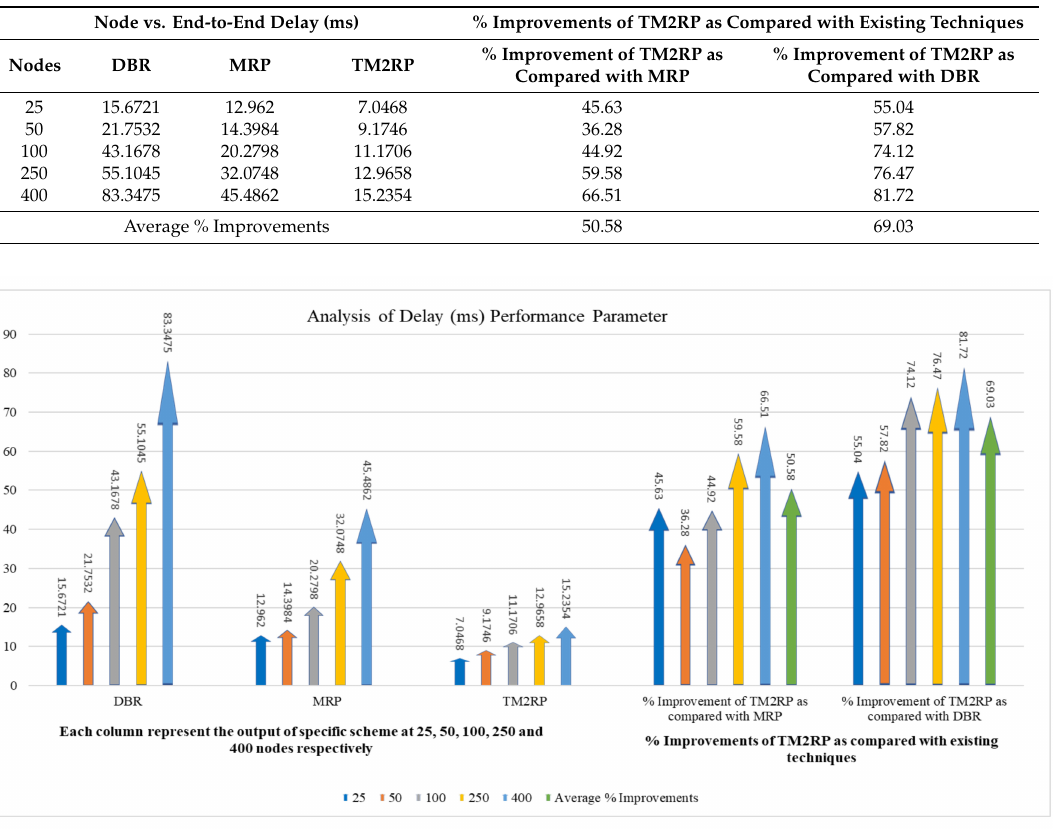
Figure 14. The statistical outcomes of the comparative protocols with regard to end-to-end